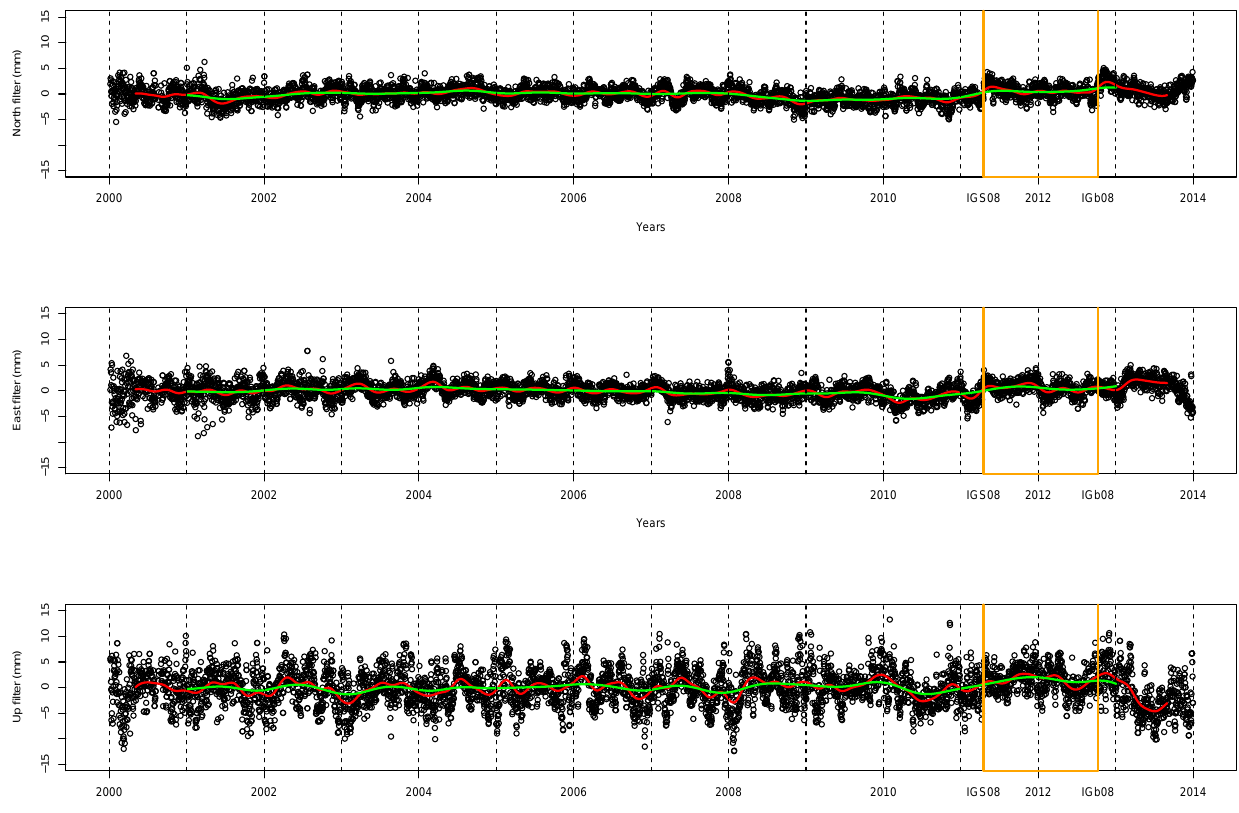
Figure 2. Common-mode stacked filter. Black circles show daily positions. Red and green curves show 1-month and 1-year time averages. Yellow vertical lines show the IGS05 – IGS08 and the IGS08 – IGb08